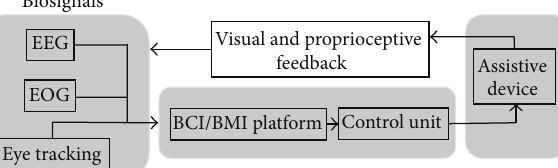
Figure 1: Organization of the University of T¨ubingen’ prototype system controlling assistive devices using brain waves and eye movements.